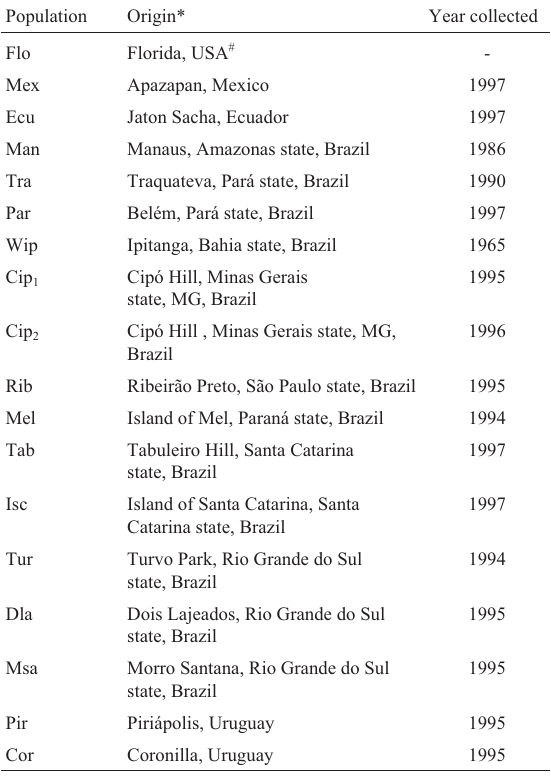
Table 1 - Geographical origin of the Drosophila willistoni populations investigated in the present